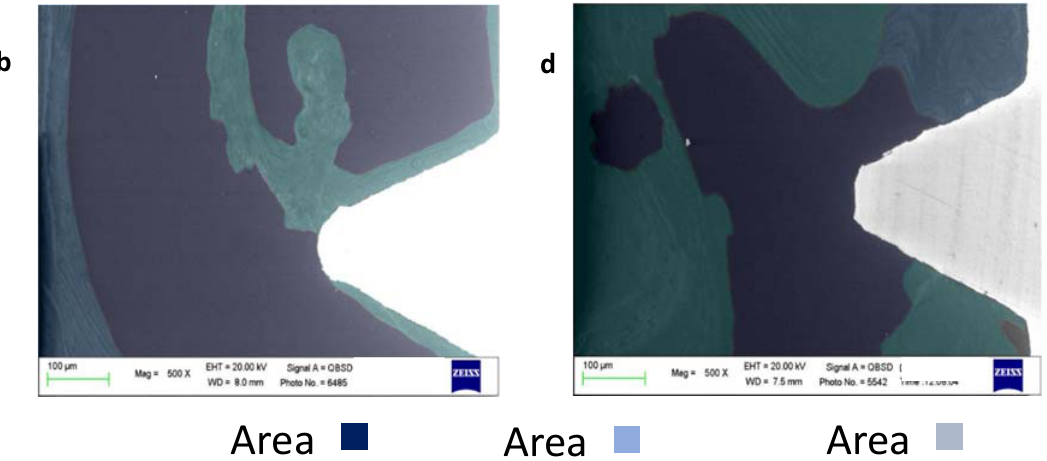
Figure 2. ESEM / EDX microanalysis of selected coronal and apical ROI of two di ff erent implants included in the study. ( a ) Coronal thread. The analysis revealed a heterogeneous bone tissue. The coronal side of the thread was in contact with moderately electron-dense bone (Area 2), while the apical side revealed highly electron-dense tissue (Area 3). Osteocytes lacunae and bone lamellae were concentrically arranged, partially in contact with the apical side of the thread. Remote bone followed a similar thread, with the presence of high mineralized bone structures (Area 3), in close contact with moderate mineralized bone (Area 2), indicating ongoing bone remodeling at the moment of the sample retrieval. ( b ) Microanalysis of the apical region revealed moderately electron-dense bone in contact with the implant thread. In this area, very low mineralized tissue was markedly present (Area 1), indicating bone marrow areas and suggesting an incomplete bone remodeling process. ( c ) Investigation of the coronal ROI revealed irregular electron-dense areas. Moderately and highly mineralized areas (Area 2 and 3) were identified on the apical side of the thread, while very low mineralized bone tissue was evident at the bone interface of the coronal side of the thread (Area 1). Bone that was distant from the implant interface revealed a heterogeneous structure (also evidencing numerous bone niches), mostly composed of Area 2 bone, suggesting new bone or bone remodeling at this site. ( d ) The apical ROI revealed the marked presence of moderately electron-dense bone tissue (Area 2) in close contact with the implant thread. Very low mineralized bone tissue (Area 1) was identified at the top of the implant thread, suggesting incomplete bone remodeling in this area. Highly mineralized bone (Area 3) was found in limited areas in contact with the implant thread, and on bone sites at a distance of approximately 500 µ m.